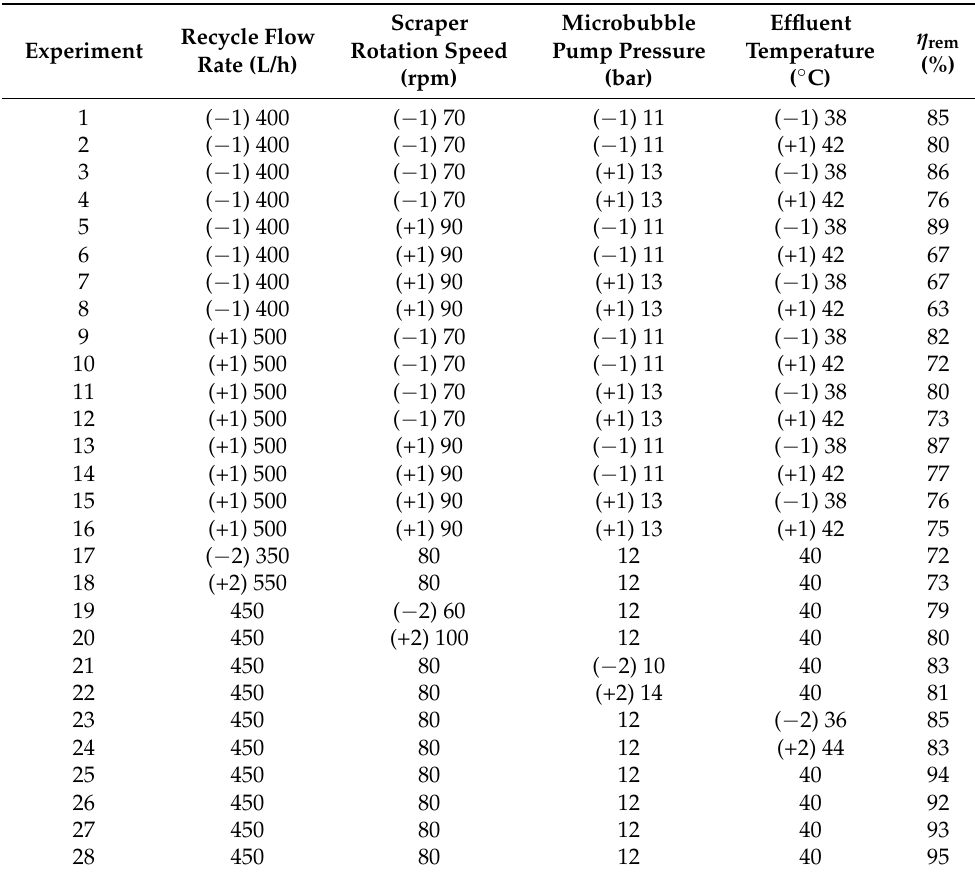
Table 4. Matrix of the central composite rotational design with coded (between brackets) and actual values of the independent variables. Response variable: oil and grease removal efficiency ( η rem